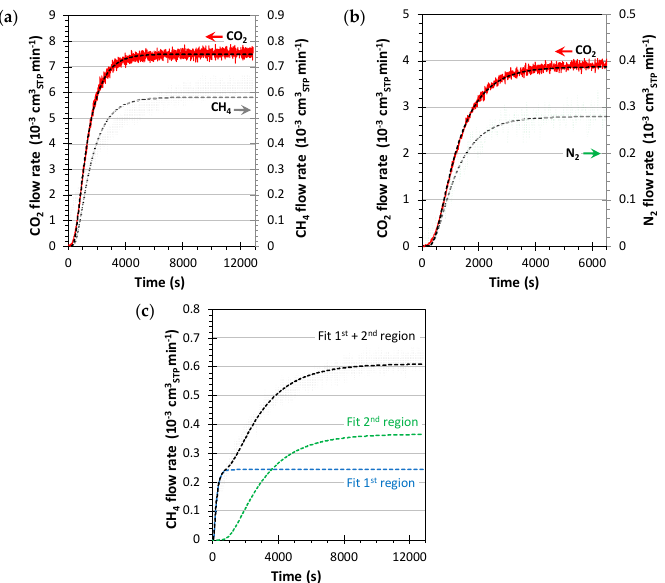
Figure 6. Permeate flow rate in the variable volume/constant pressure instrument for MMMs based on Pebax ® 1657/Cu II2 (S,S)-hismox·using ( a ) the binary mixture CO 2 /CH 4 (35/65 v/v) and ( b ) the binary mixture CO 2 /N 2 (15/85 v/v) with the N 2 signal displayed as the 5-point moving average for noise reduction. Fits are reported in dotted black lines and are calculated on the rough data using Equation (9). ( c ) Two-step fit CH 4 permeation curve. Figure adapted from [36].